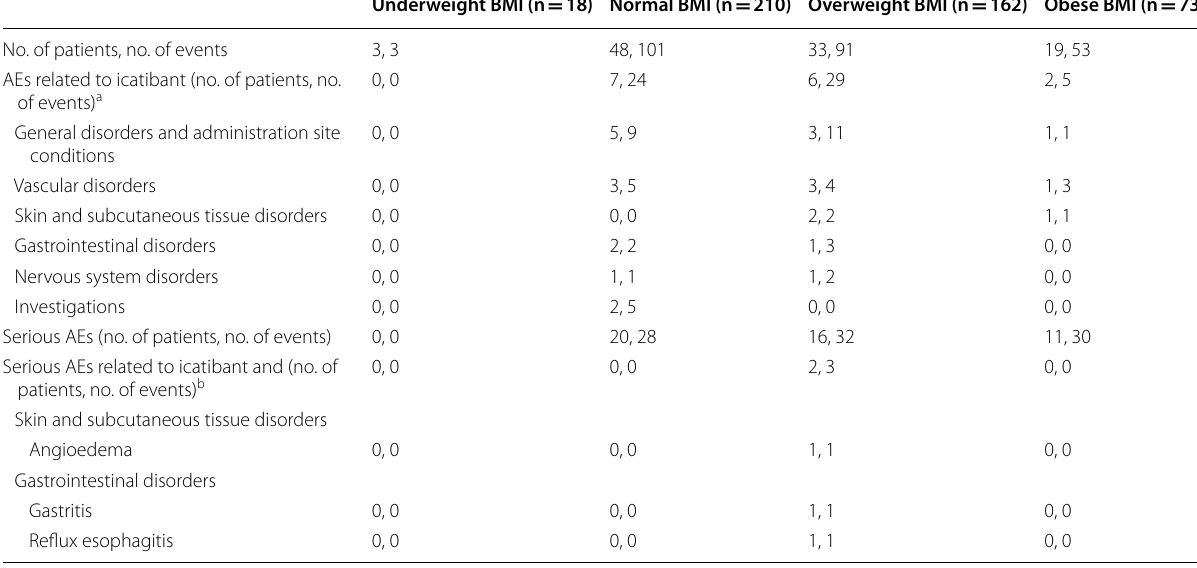
Table 7 AEs in all patients with